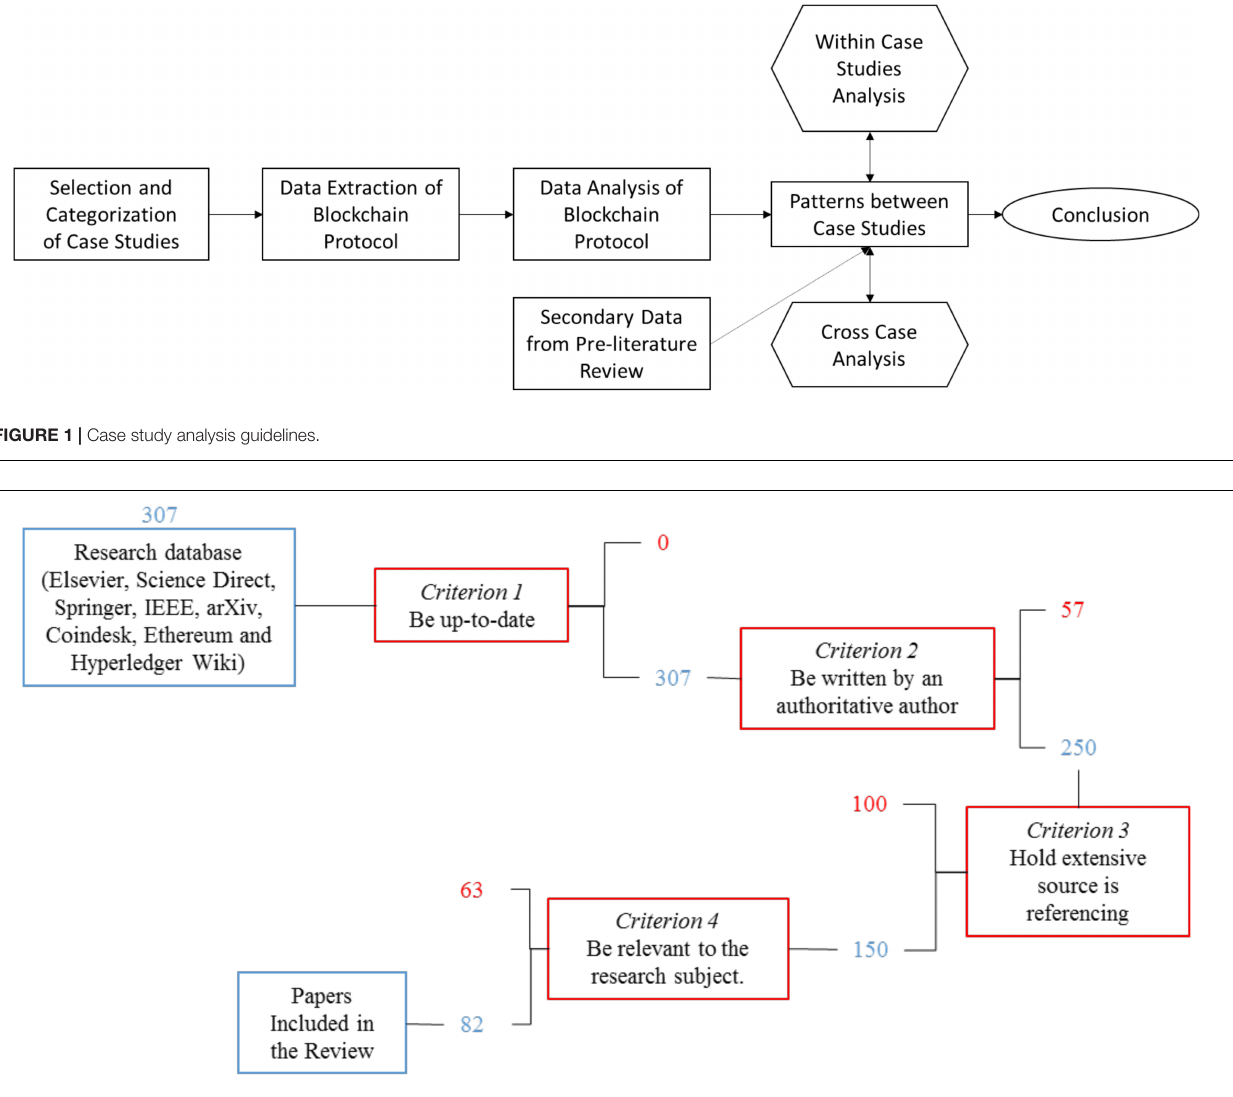
FIGURE 2 | Pre-literature review filtering process and results.